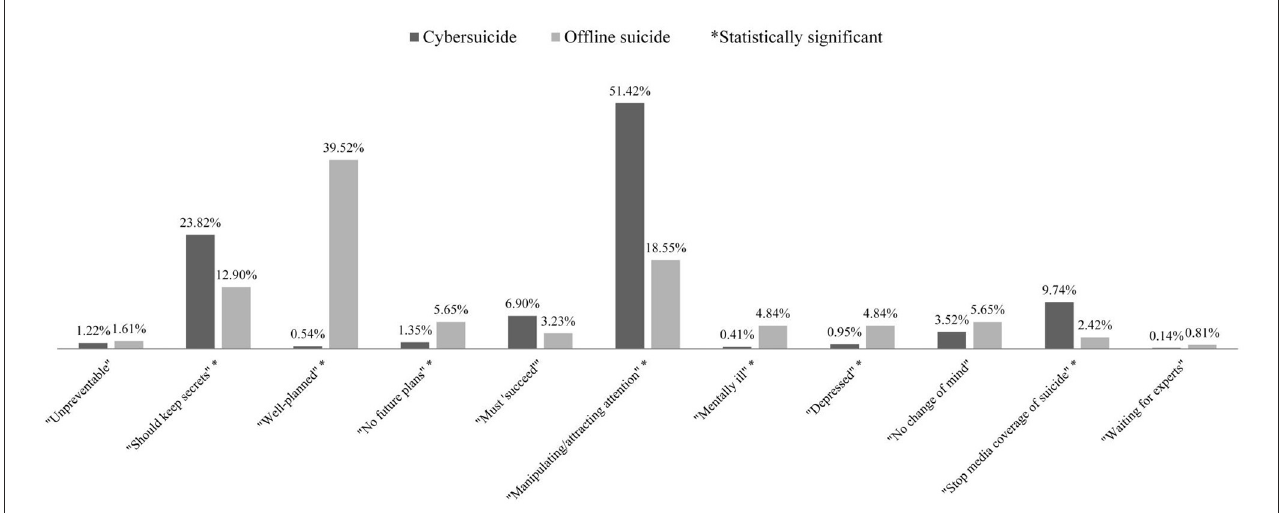
FIGURE2 Comparison of proportions of posts indicating specific false knowledge types between cybersuicide and offline suicide. *Statistically